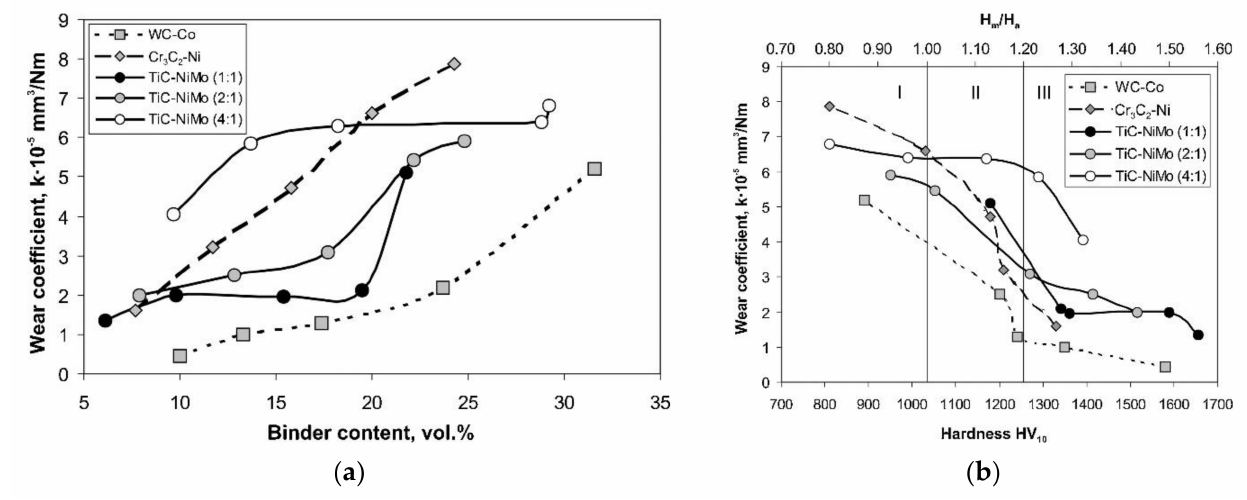
Figure 5. Wear coefficients vs. binder content ( a ) and bulk hardness ( b ) of TiC- and Cr 3 C 2 -cermets, and WC-Co hardmetals [59].